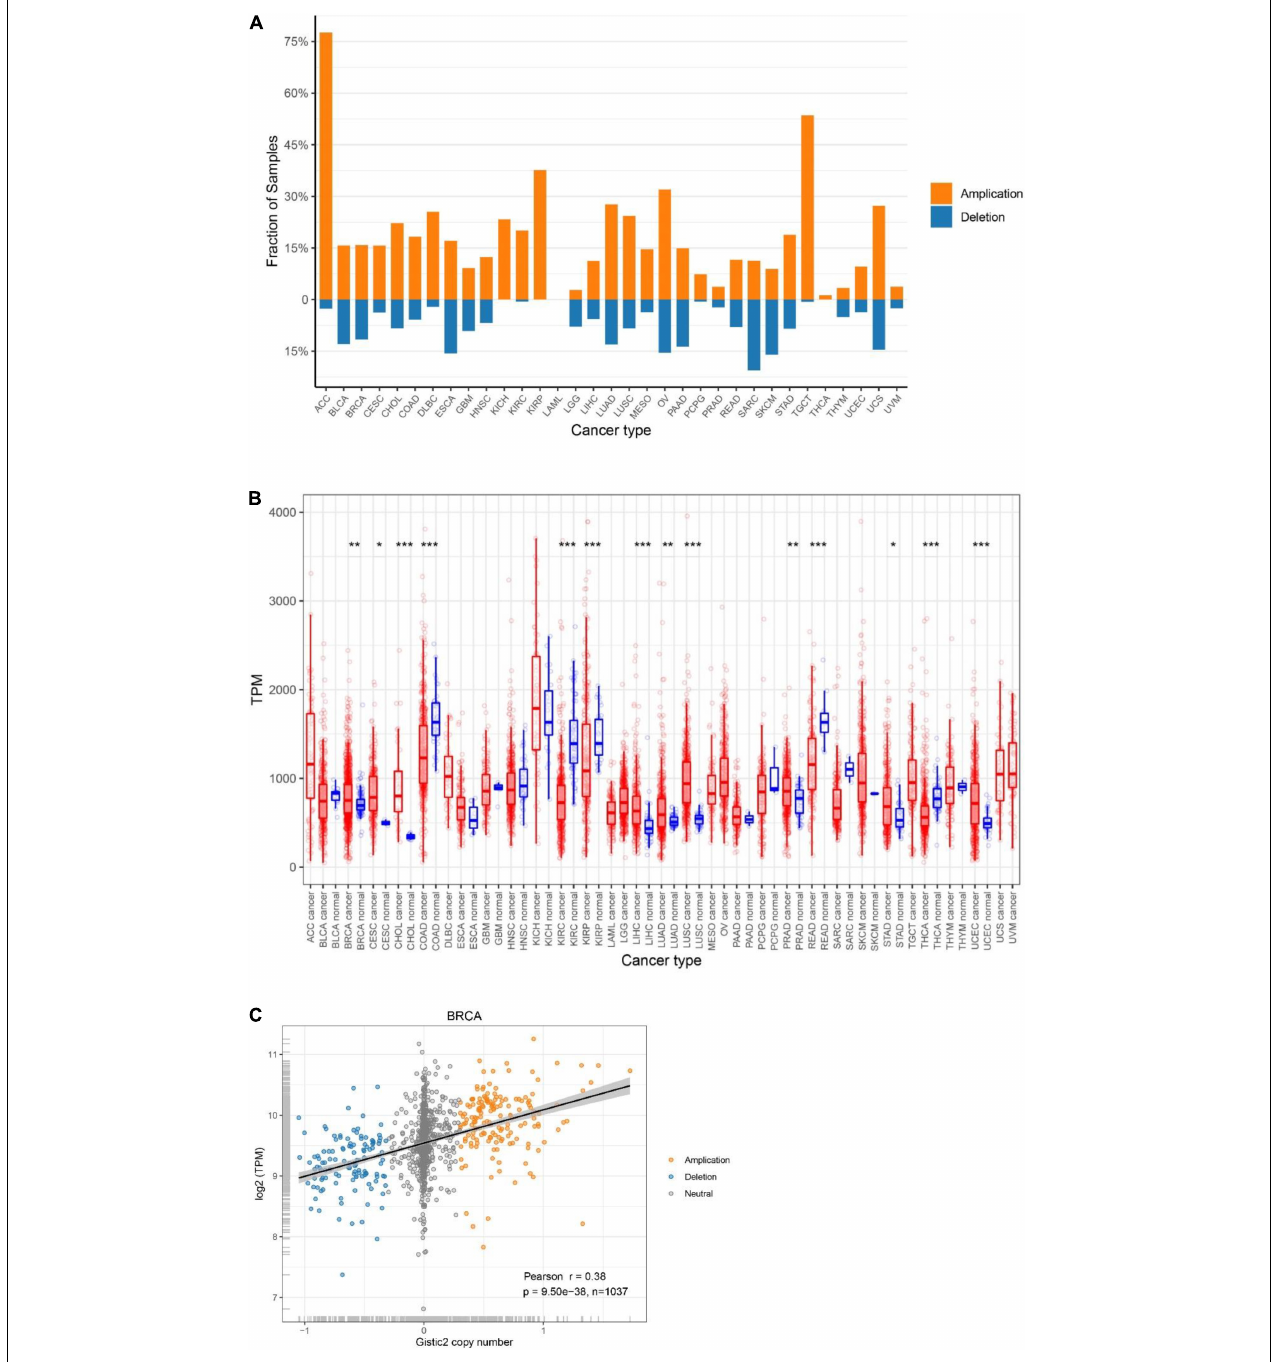
FIGURE 1 | Genetic characteristics of ATP5B in TCGA pan-cancer. (A) ATP5B amplification and deletion frequency in TCGA cancer types. ACC, adrenocortical carcinoma; BLCA, bladder urothelial carcinoma; BRCA, breast invasive carcinoma; CESC, cervical squamous cell carcinoma and endocervical adenocarcinoma; CHOL, cholangiocarcinoma; COAD, colon adenocarcinoma; DLBC, lymphoid neoplasm diffuse large B-cell lymphoma; ESCA, esophageal carcinoma; GBM, glioblastoma multiforme; HNSC, head and neck squamous cell carcinoma; KICH, kidney chromophobe; KIRC, kidney renal clear cell carcinoma; KIRP, kidney renal papillary cell carcinoma; LAML, acute myeloid leukemia; LGG, brain lower grade glioma; LIHC, liver hepatocellular carcinoma; LUAD, lung adenocarcinoma; LUSC, lung squamous cell carcinoma; MESO, mesothelioma; OV, ovarian serous cystadenocarcinoma; PAAD, pancreatic adenocarcinoma; PCPG, pheochromocytoma and paraganglioma; PRAD, prostate adenocarcinoma; READ, rectum adenocarcinoma; SARC, sarcoma; SKCM, skin cutaneous melanoma; STAD, stomach adenocarcinoma; TGCT, testicular germ cell tumors; THCA, thyroid carcinoma; THYM, thymoma; UCEC, uterine corpus endometrial carcinoma; UCS, uterine carcinosarcoma; UVM, uveal melanoma. (B) Pan-cancer expression landscape of ATP5B. The expression abundance is measured by transcripts per million (TPM). (C) ATP5B mRNA expression compared to ATP5B copy number values in breast cancer.